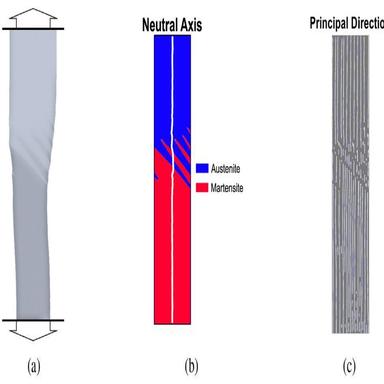
(a) Shape of the specimen with amplified lateral displacements; (b) map of the specimen showing the austenitic and martensitic regions, and the position of the neutral axis represented by a white line (calculated using Eq. (5)); (c) principal directions determined on the measured strains. All pictures are in relation to the instant P, as indicated in a.